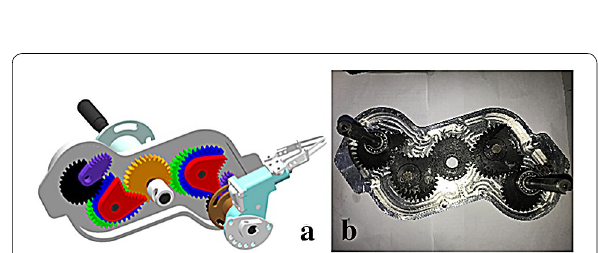
Figure 17 Gears of the planetary gear train: a virtual and b physical prototype